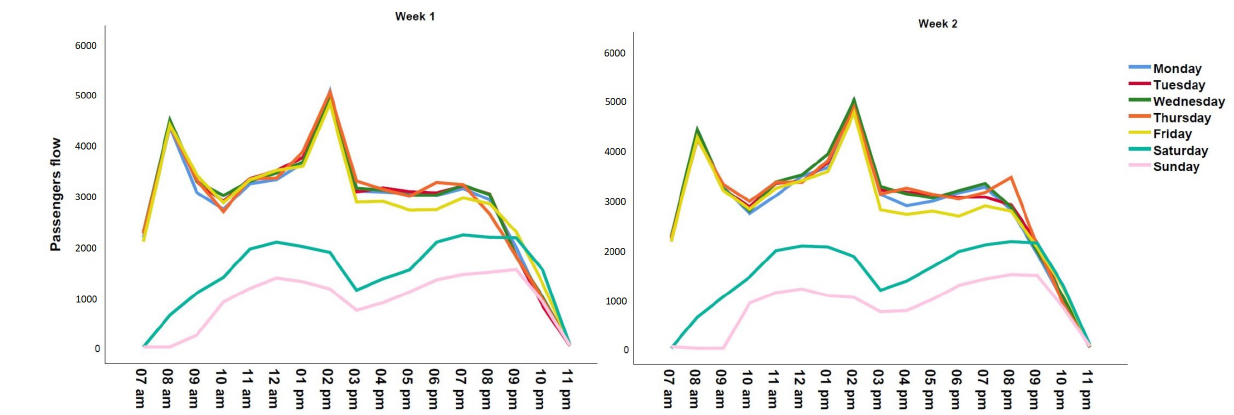
Figure 2. Time-varying diagram of passenger flow by weeks.